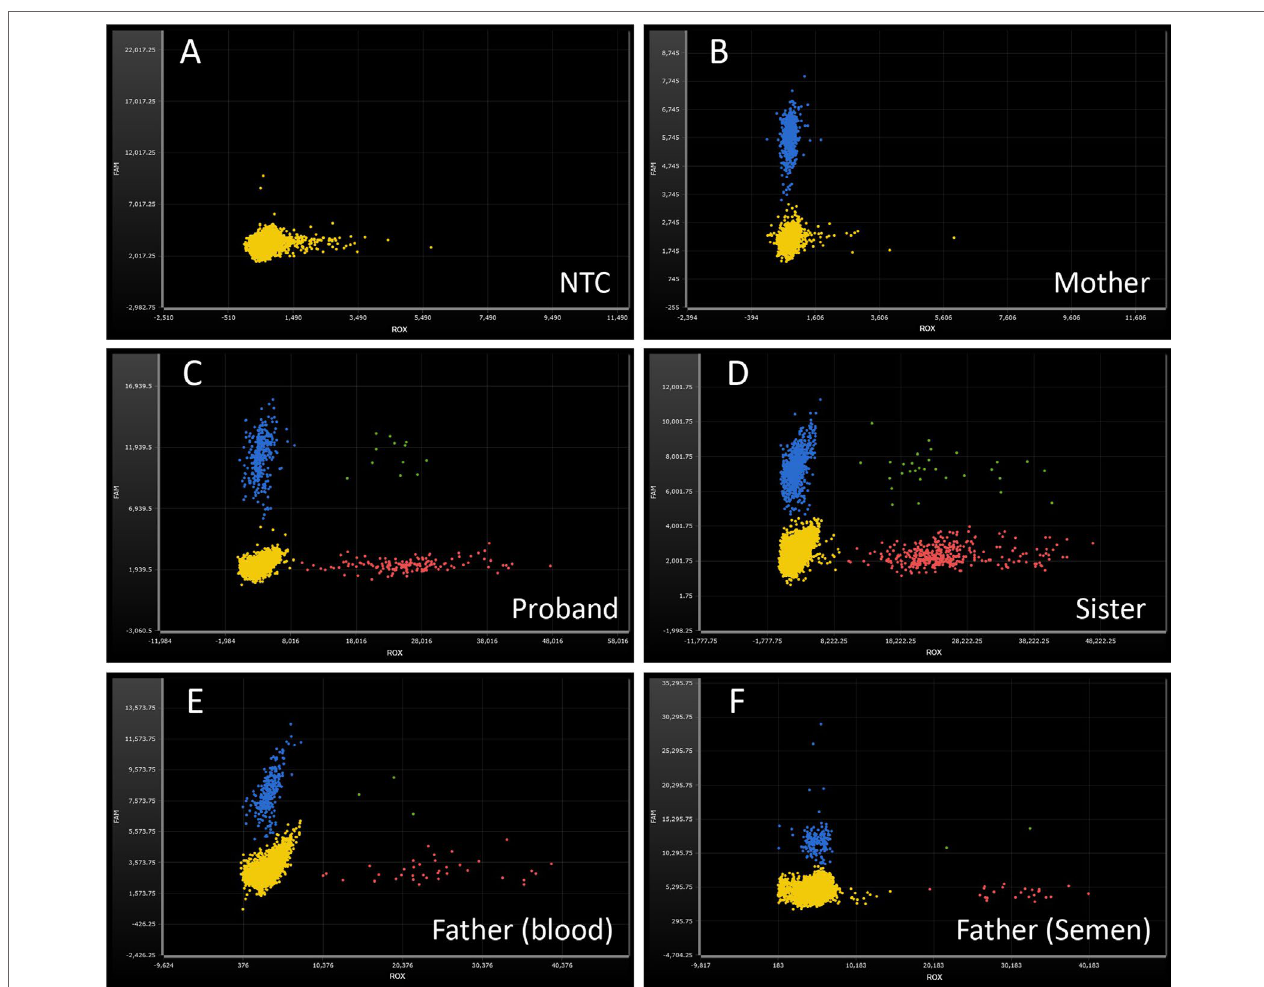
FIGURE 3 | Droplet digital PCR analysis for the mutant frequencies of SATB2 gene. ROX-labeled probe detects the delete mutation of SATB2 gene (red dots). 6-FAM-labeled probe detects the reference gene PARP2 (blue dots). Green dots, ROX and 6-FAM double positive. Yellow dots, no amplification. (A) No-template control, NTC; no amplification on both fluorescence channels. (B) wild type, DNA from the proband’s mother; normal amplification on FAM channel, while no amplification on ROX channel. (C, D) heterozygosity, DNA from the proband and his sister, respectively; the ratios of ROX/FAM were close to 0.50. (E, F) mosaicism, DNA from the proband’s peripheral blood and semen of the father; the ratios of ROX/FAM were 13.16% and 16.68%,